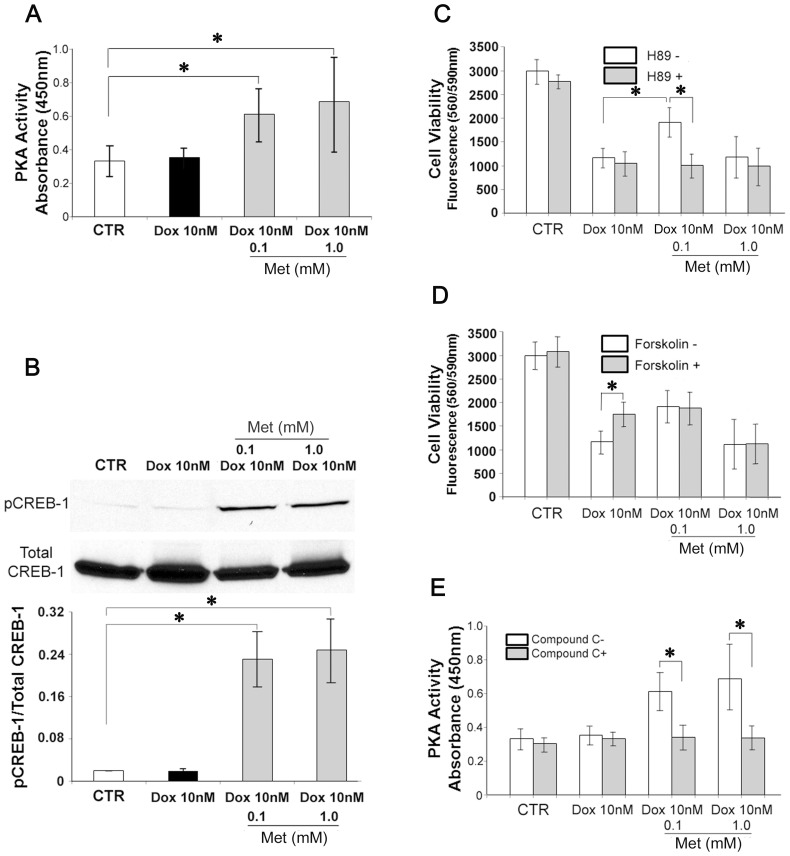
Protective effect of Met against Dox induced cytotoxicity is mediated by cAMP-PKA-CREB1 signaling pathway.(A) H9c2 cardiomyoblasts were cultured with reduced FBS (1%) for 72 hours, with indicated conditions and then cell lysates were isolated with RIPA buffer supplemented with appropriate phosphatase inhibitors. Protein kinase-A (PKA) activities in the cell lysates were measured as described in Materials and Methods. (B) H9c2 cell lysates from the 72 hour-culture were subject to Western blotting using antibodies against phosphorylated or total cAMP response element-binding protein-1 (CREB-1). The histograms show the densitometric scanning results. (C) H9c2 cells were cultured for 72 hours with reduced FBS (1%) under indicated conditions with or without H-89 (10 µM). The cell viabilities were evaluated as described. (D) H9c2 cells were cultured for 72 hours with reduced FBS (1%) for hours under indicated conditions with or without forskolin (1 µM). The cell viabilities were evaluated as described. (E) H9c2 cells were cultured for 72 hours with reduced FBS (1%), under indicated conditions with or without compound-C (10 µM) and then the cell lysates were evaluated for PKA activities. Values represent mean ± S.D. (n = 4) from quadruplicate samples for each treatment at varying treatment conditions. *, Statistically significant (p<0.05).